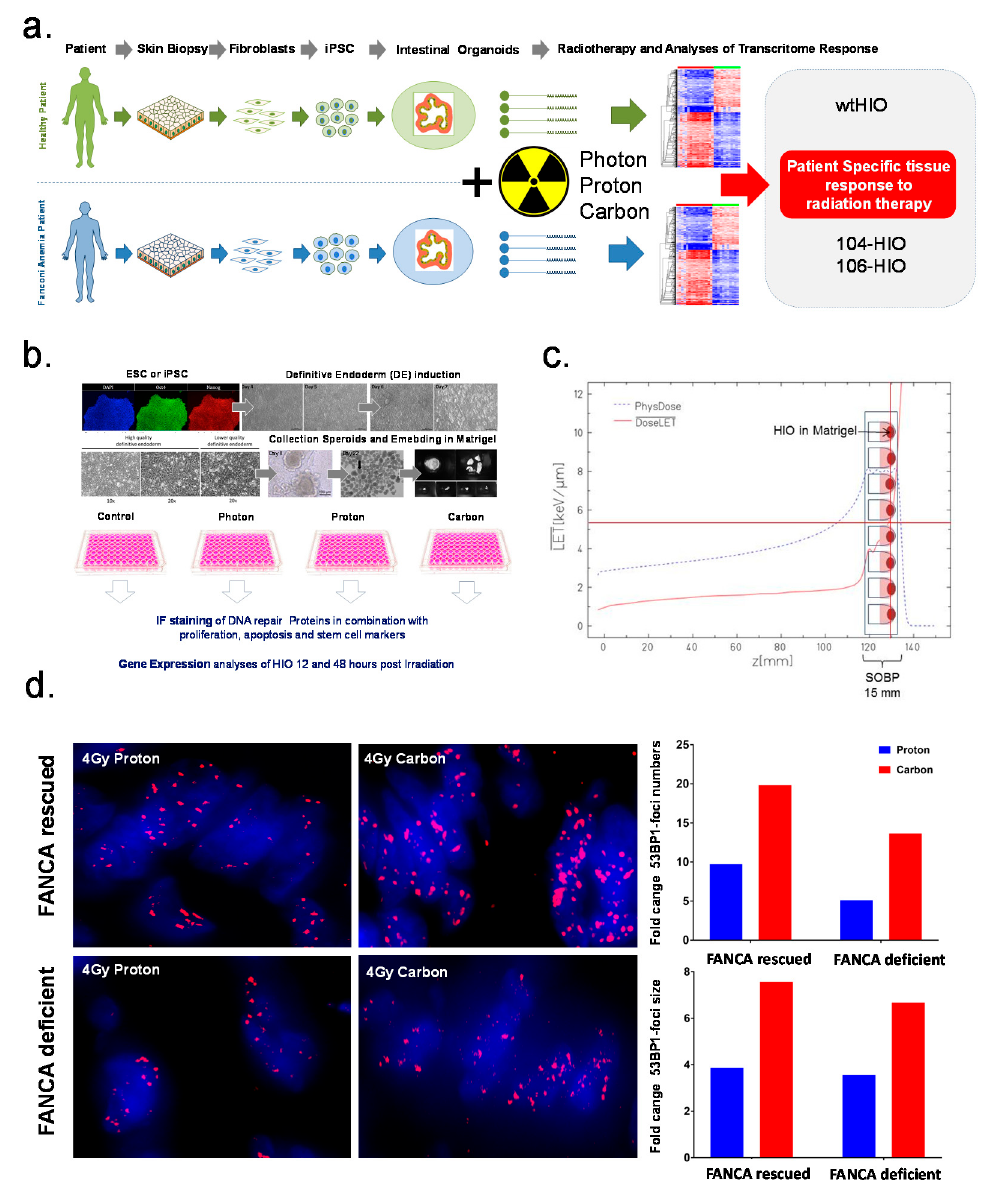
Figure 1. Irradiation of pluripotent derived human intestinal organoids with photon, proton and carbon irradiation. ( a ) Schematic outline on how organoids can be used to identify molecular surrogates of normal tissue radiation sensitivity and toxicity ( b ) Experimental outline of the study. Images of di ff erent stages of organoid development were kindly provided by the Center for Stem Cell and Organoid Medicine, Cincinnati. Human intestinal organoids (HIO) were generated as described previously and then embedded singularly in Matrigel in 96-plates. Following exposure to 4 Gy photon, proton and carbon irradiation HIO were cryo frozen for IF staining and stored for subsequent RNA isolation. ( c ) LEM prediction of carbon ions and positioning of organoids for irradiation. ( d ) Radiation-induced repair foci were visualized in cryo sections of irradiated HIO with IF stainings of 53BP1. The intensity of radiation-induced damage in HIO was quantified by measuring the 53BP1 numbers and size per cell. Represented values are normalized to background levels of 53BP1-foci.